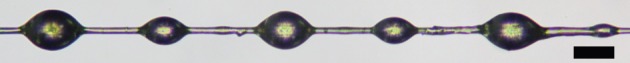
Photograph (scale bar, 20 μm) of a representative sample of N. pilipes spiral silk showing that there were two distinct sizes of droplets: large (primary) droplets and small (secondary) droplets.